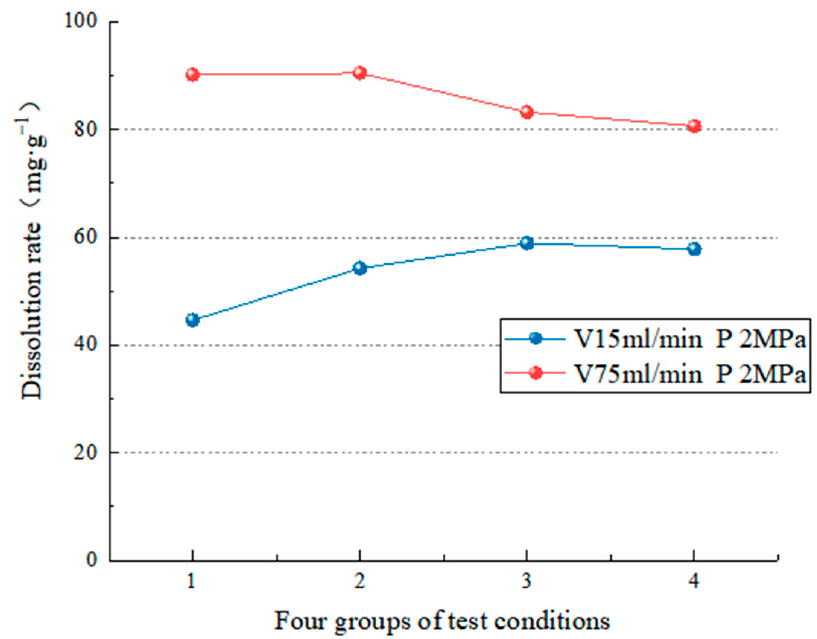
Figure 11. Comparison of the dissolution rate at a pressure of 2 MPa.